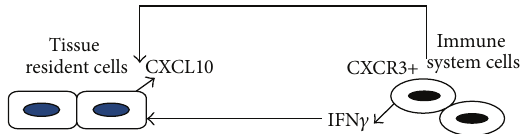
Figure 2: CXCL10-CXCR3 axis. CXCL10 secreted by different types of organ-resident cells under IFN 𝛾 induction is a potent chemoattractant for CXCR3-positive immune cells, in particular for activated T cells. T cell recruitment to sites of inflammation leads to an enhanced local increase of IFN 𝛾 , which, in turn, stimulates CXCL10 secretion by tissue cells; thus, a self-promoting inflammatory loop is established between resident and immune cells, making CXCL10-CXCR3 axis a therapeutic target for resolution of